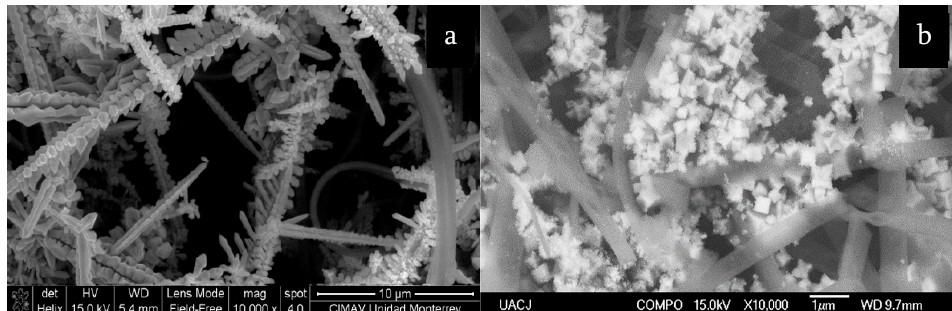
Figure 7. SiO 2 –TiO 2 –Ag fibrous composite with SERS activity ( a ) and hydroxyapatite–SiO 2 –Ag fibers with SERS and SEIRAS activity ( b ).